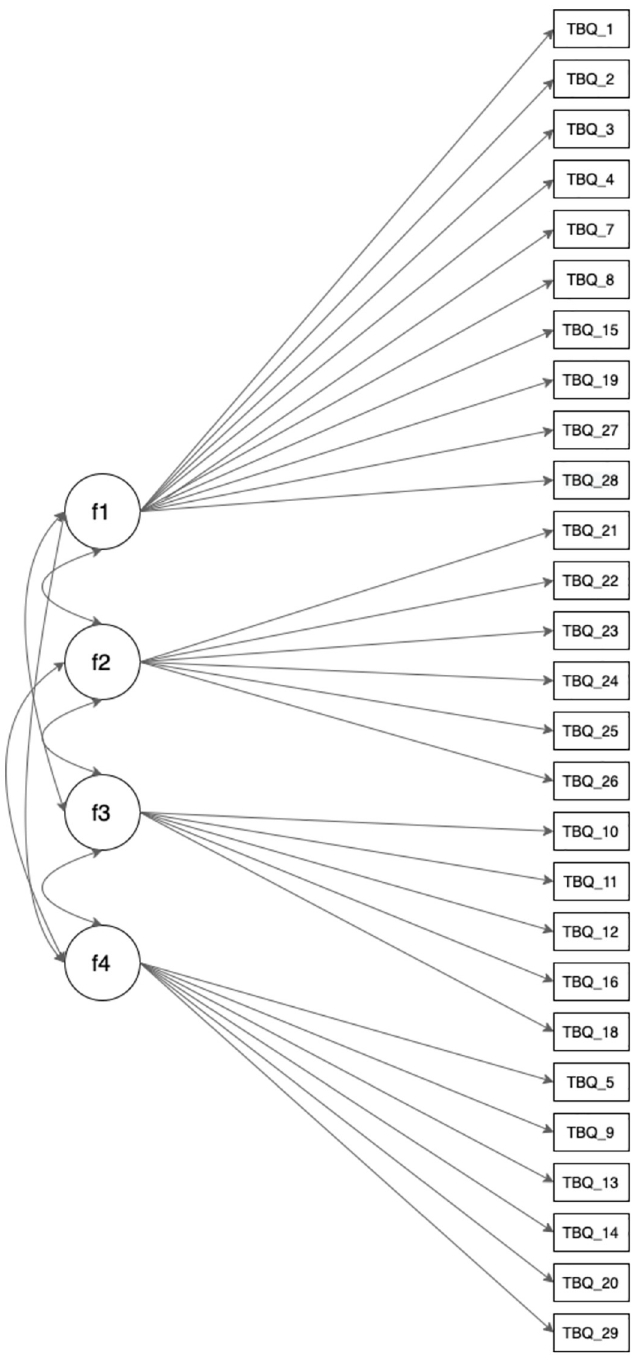
Fig 1. Graphical representation of the four-factor structure of the Tactile Biography Questionnaire (TBQ). https://doi.org/10.1371/journal.pone.0274477.g001 this model (compared to the previous one) did not result in a significant degradation of fit ( Δ CFI = < .001; Δ RMSEA = .006). Lastly, residuals variances were constrained to be equal across the two groups (( Λ , τ , Θ ) M = ( Λ , τ , Θ ) F ), and fit indexes showed that this model did not result in a significant change of fit ( Δ CFI = < .001; Δ RMSEA = < .001).